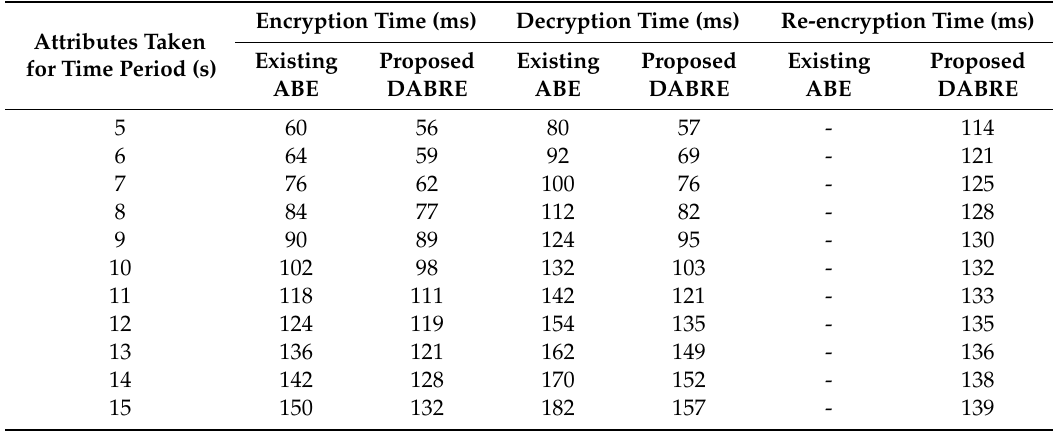
Table 2. Encryption time, decryption time and re-encryption time analysis of the proposed